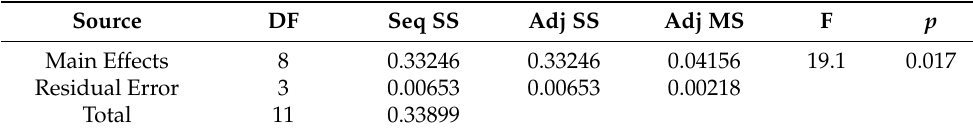
Table 2. ANOVA for quadratic model of pigment extracted from V. halodenitrificans DASH. Source DF Seq SS Adj SS Adj MS F p Main Effects 8 0.33246 0.33246 0.04156 19.1 0.017 Residual Error 3 0.00653 0.00653 0.00218